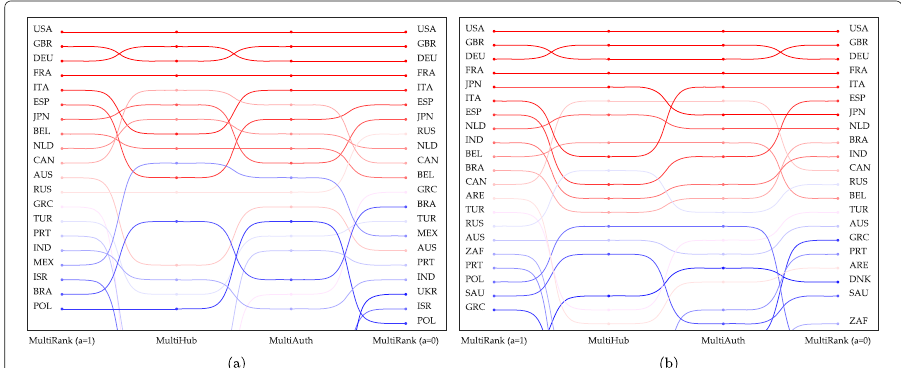
Fig. 6 Node rankings in different configurations: cross section in 2003 ( a ), cross section in 2010 ( b ). For the MultiRank rankings the other parameters are in both cases s = 1 and γ = 1 Node rankings